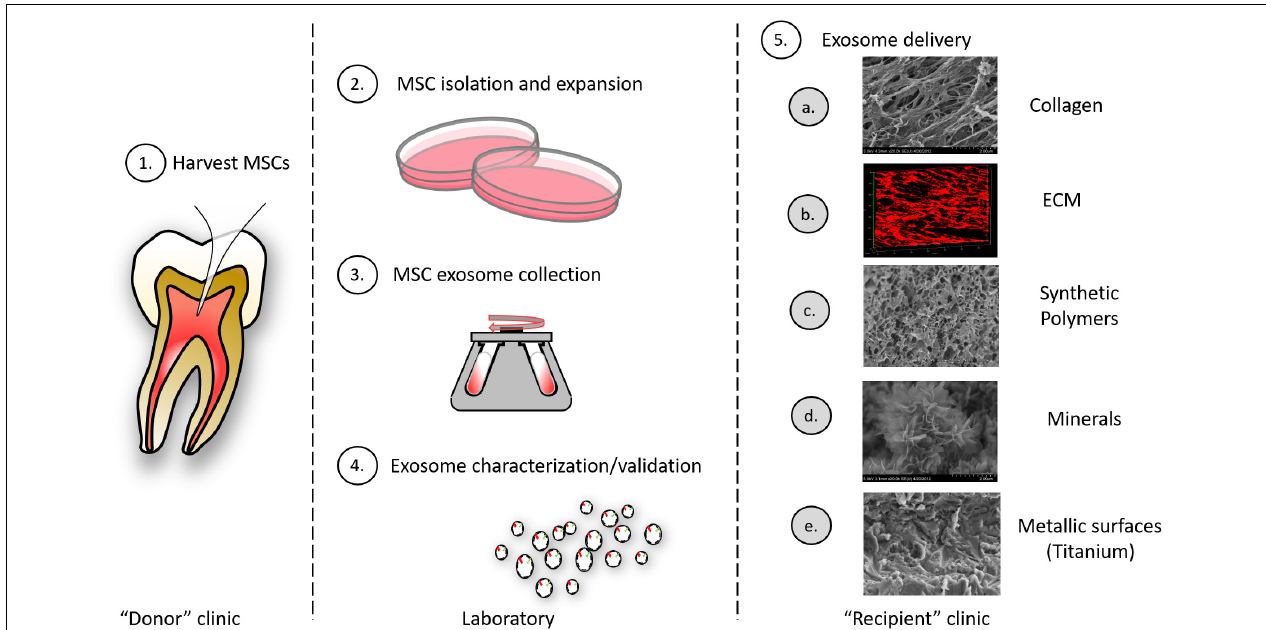
FIGURE 4 | Exosomes as therapeutic agents: exosomes may be clinically isolated from MSC isolated oral tissues (e.g., perhaps by pulpectomy). (1) This could be an autogenous scheme or, alternatively, MSCs could be isolated from pulp of extracted teeth and derived exosomes used in an allogenic scheme. (2) MSCs must be isolated and expanded and conditioned media from cells collected. (3) MSC exosomes are collected from conditioned media by different methods including ultracentrifugation, immune-isolation, and precipitation. (4) Exosomes must be characterized according to their size and integral membrane protein composition; engineered exosome cargo must be defined by miRNA or protein analysis. (5) Exosomes can be delivered to a variety of different tissues using different carriers that include: (a) collagen matrices, (b) decellularized ECM, (c) synthetic polymers (bioprinted carriers), (d) mineral scaffolds, and (e) metallic